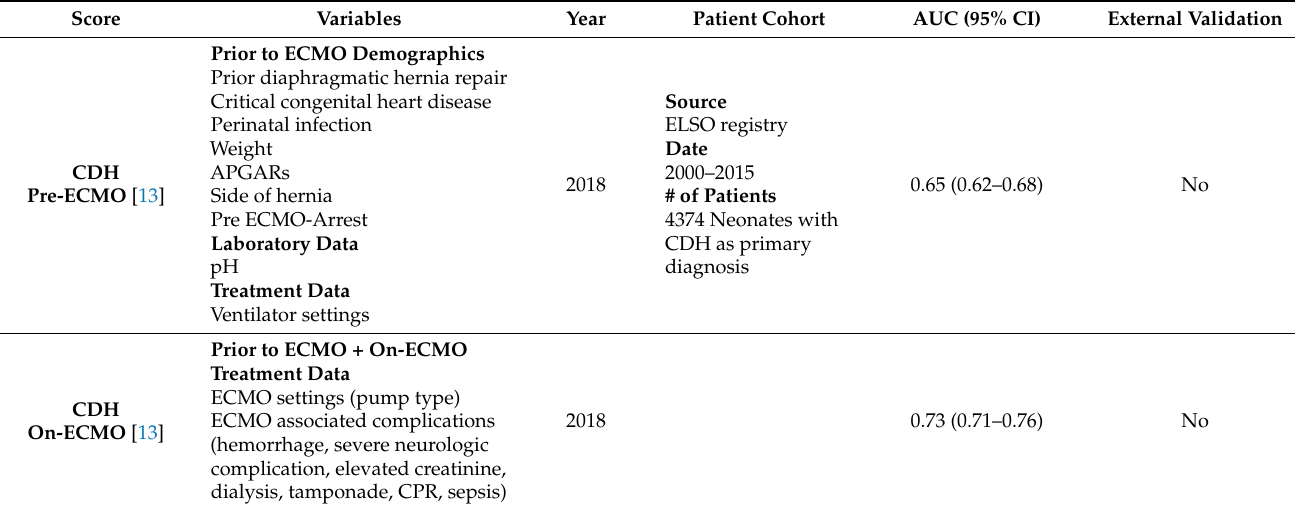
Table 2. Prognostication scores for neonatal congenital diaphragmatic hernia.